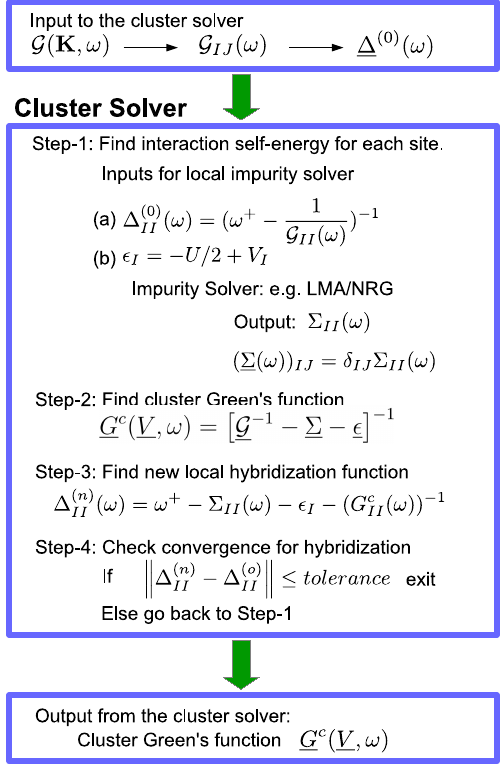
Figure 26. The detailed algorithm implemented to solve the interacting disordered problem with a cluster solver built by combining statistical DMFT and a local impurity solver which could